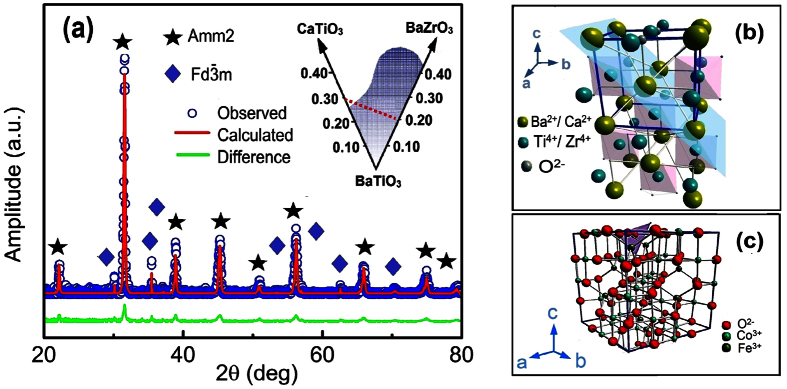
(a) The XRD pattern of the BCZT85-CFO15 ceramics measured at room temperature and the pattern calculated by Rietveld refinement based on the sum of an orthorhombic structure with the space group Amm2 shown in (b) and cubic inverse spinel structure with space group  shown in (c). The inset in panel (a) shows the ternary phase diagram of BaTiO3, CaTiO3, and BaZrO3 adapted from Ravez et al.24. The dashed red line represents the full composition BZT-xBCT.